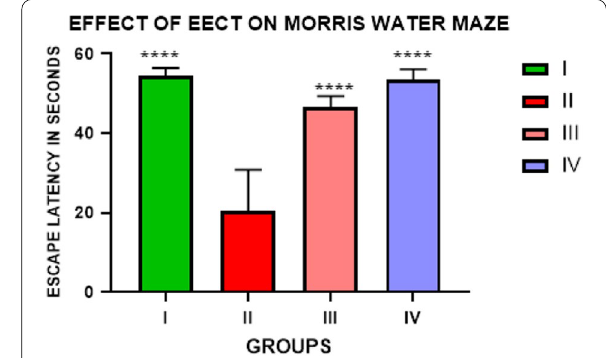
Fig. 3 Effect of EECT on Morris water maze